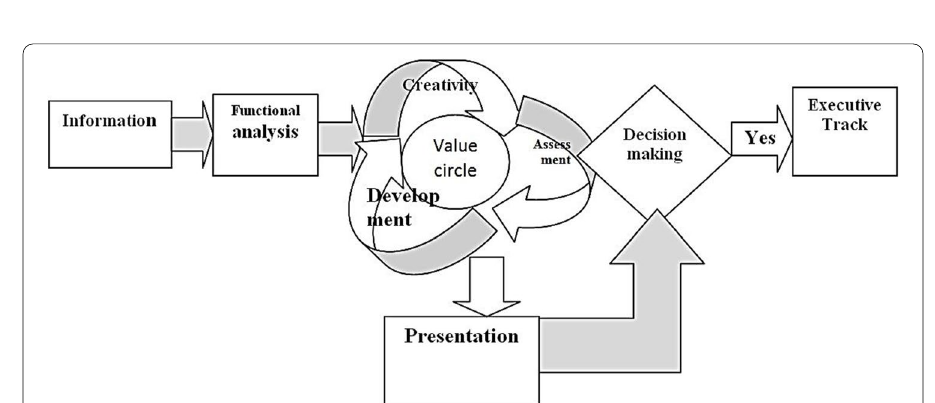
Fig. 1 The schematic of the value analysis process in VE